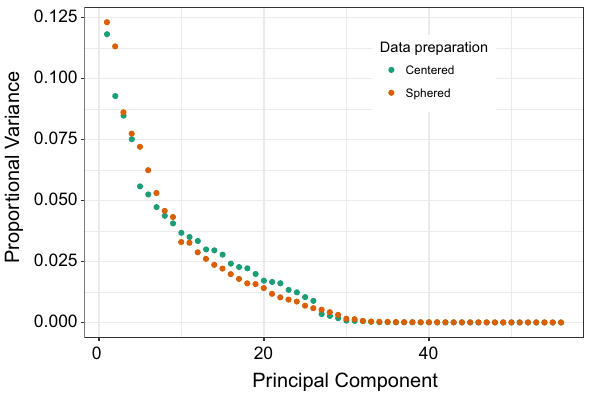
Fig. 5 Proportional variance explained by the principal components of the 56 dimensional parameter space. To capture all the variation, one would need close to 30 principal components, but around 6 captures about 50% of the variation. Both data preparations produce similar variance explanation, but the differences are enough to matter in some